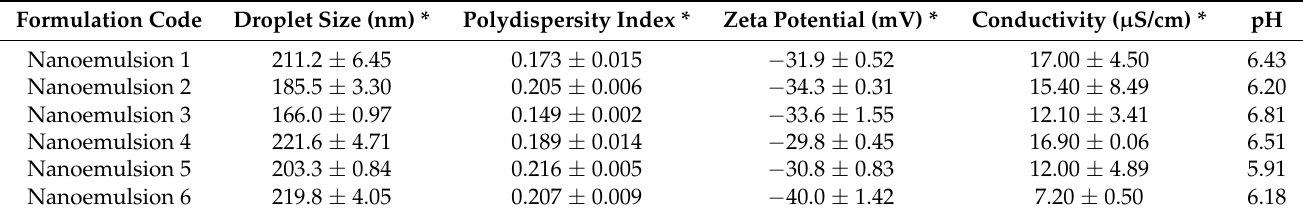
Table 2. Characterization results of